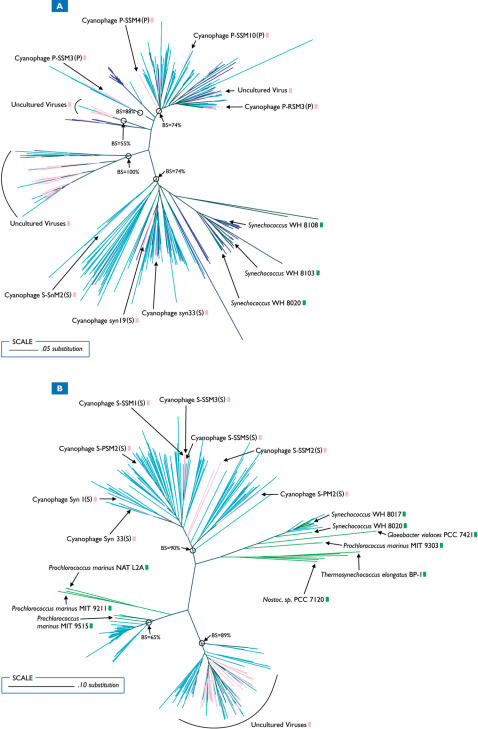
Phylogenetic trees of all GOS and publicly available psbA (A) and psbD (B) sequences.BS indicates bootstrap values. GOS and public viral sequences are colored aqua and pink respectively. GOS and public prokaryotic sequences are navy blue and lime green respectively.